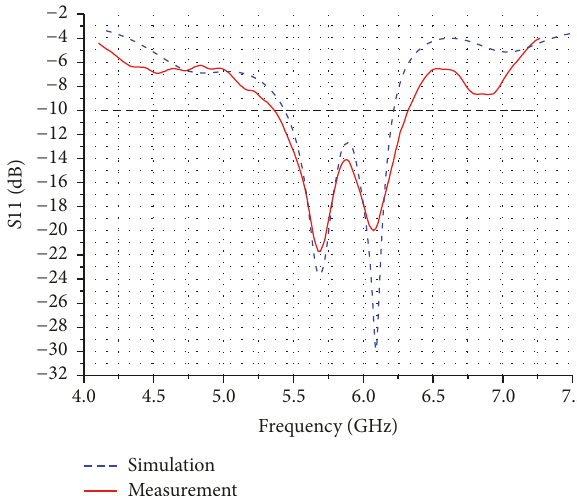
Figure 8: Measured and simulated |𝑆11| of the 1 × 2 linear array.